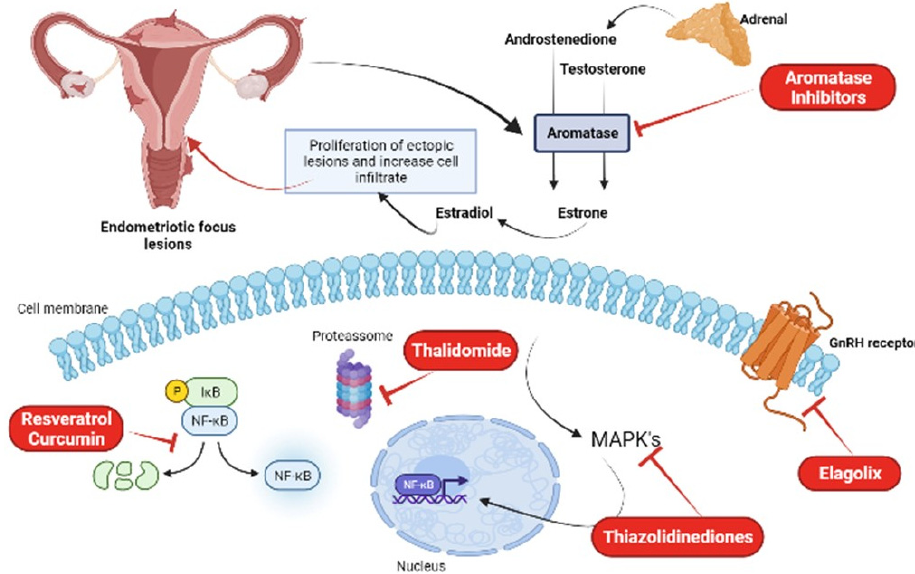
Figure 3. New treatment options for the treatment of endometriosis: aromatase inhibitors, thalido- mide, thiazolidinediones, elagolix, resveratrol, and curcumin. Figure created in Biorender.com.